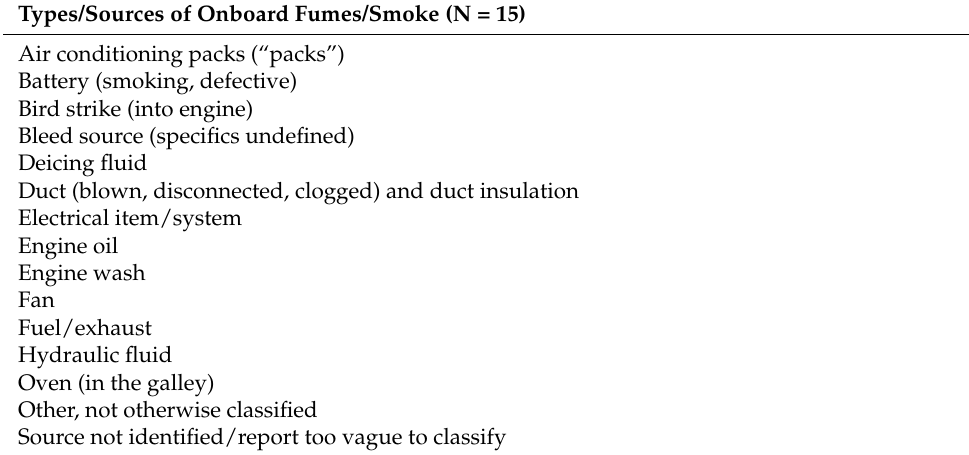
Table 1. Types/sources of onboard